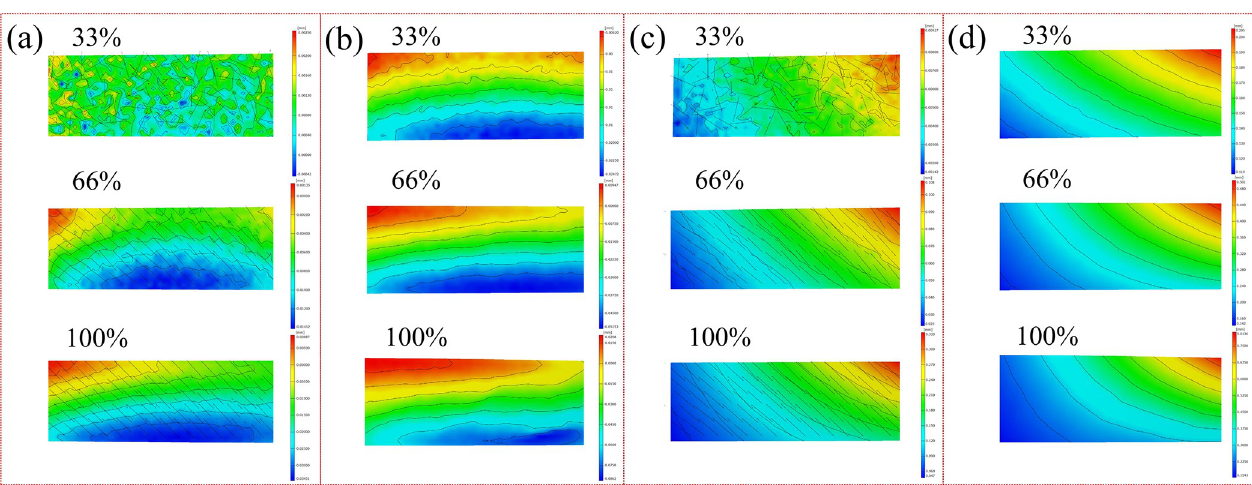
Fig 6. Strain contour of both long axis length and short axis length at different stages (a) Long axis of specimen under single torsion load (b) Long axis of specimen under compression-torsion coupling loads (c) Short axis of specimen under single torsion load (d) Short axis of specimen under compression-torsion coupling loads.